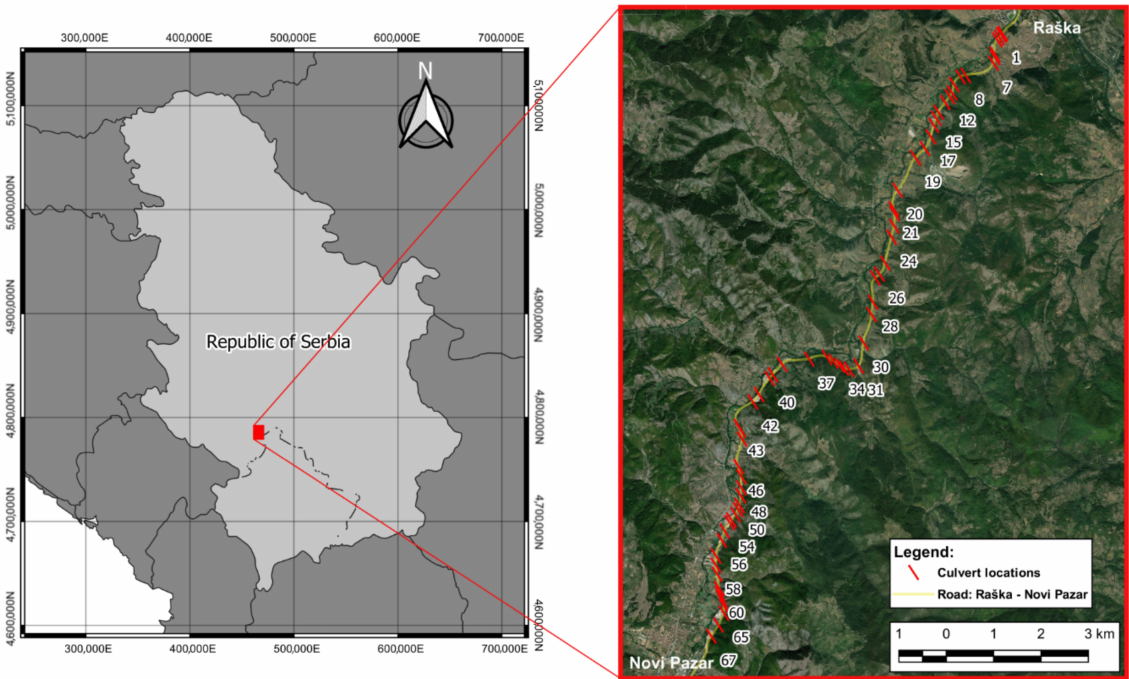
Figure 1. The locations of culverts on the analyzed road section.